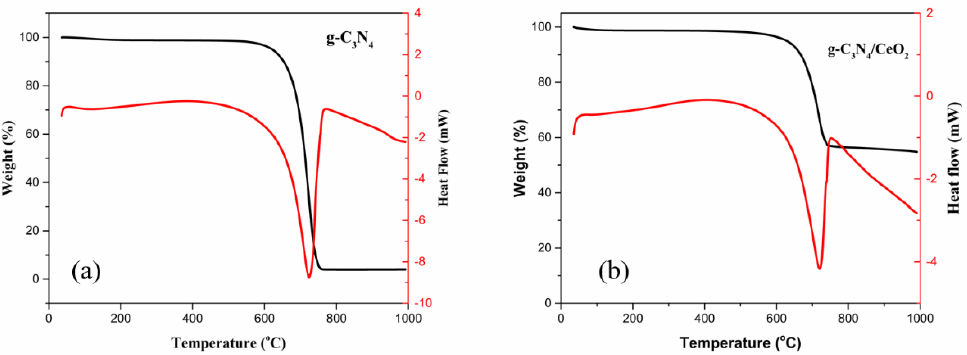
Figure 8. TG-DSC analysis of ( a ) g-C 3 N 4 and ( b ) g-C 3 N 4 /CeO 2.